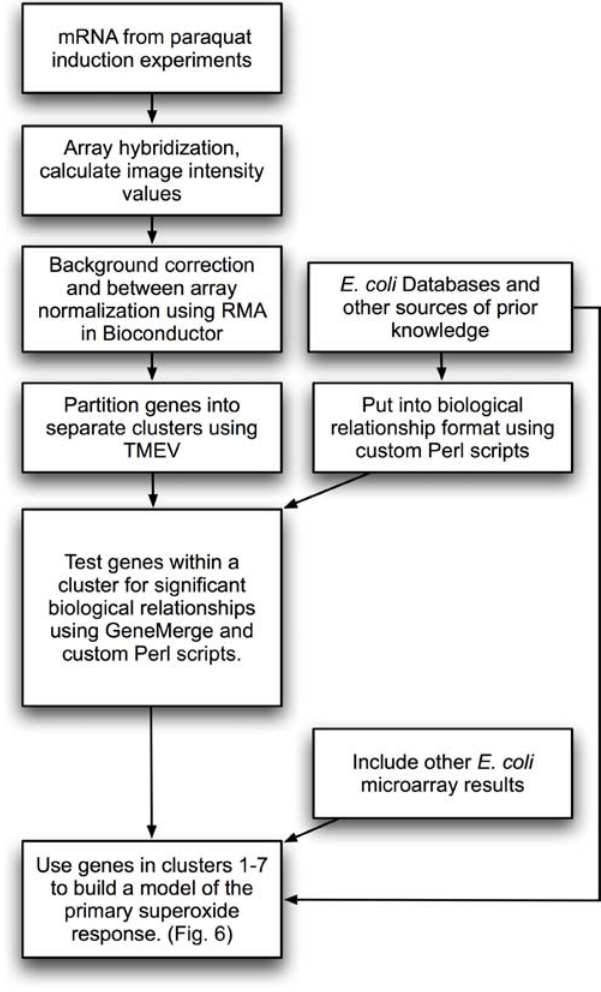
Figure 2. Expression analysis work flow.